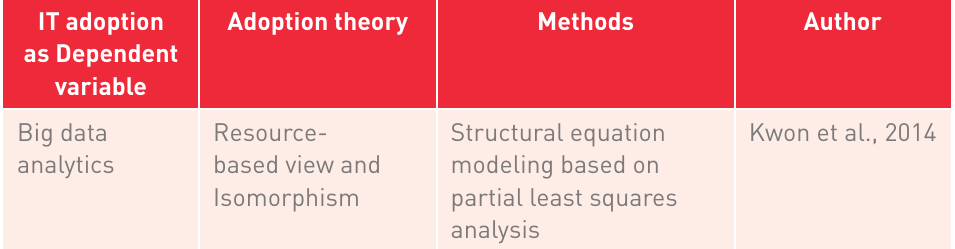
modeling based on partial least squares